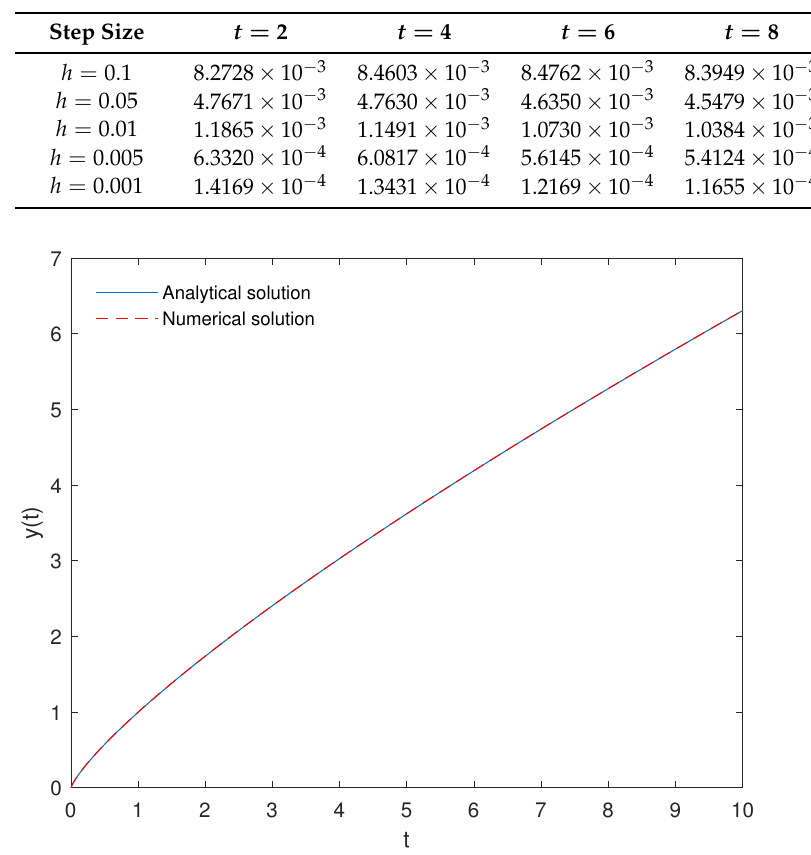
Figure 1. The time domain response of EFOTF